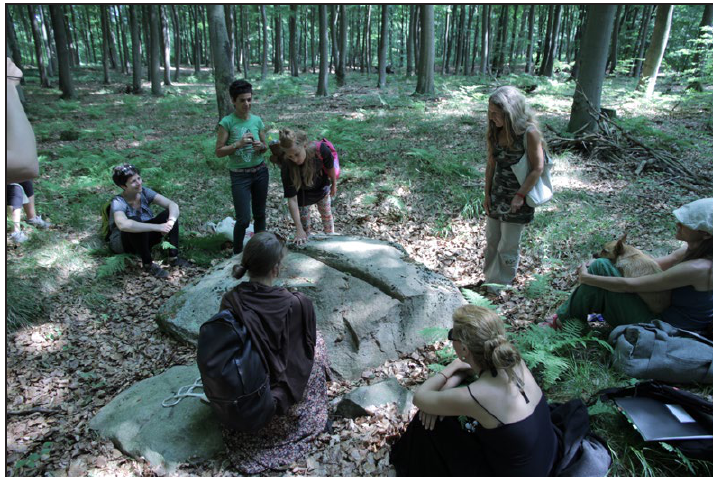
Figure 6: Deirdre Donoghue, ‘The Maternal as an Attitude, Maternal Thinking and The Production of Time and Knowledge’ (2013–2014). Note from the artist: This photo- graph is taken at the launch of the artistic research project ‘The Maternal as an Atti- tude, Maternal Thinking and The Production of Time and Knowledge’ (2013–2014) initiated by Deirdre M. Donoghue and kindly supported by Witte de With Cen- tre for Contemporary Art. This first public event, which took form as a picnic com. workshop was a collaboration between Deirdre M. Donoghue, Witte de With Cen- tre for Contemporary Art (NL), the artist’s initiative Oda Projesi from Istanbul (TR), Astrid Noack’s Ateliers (DK) and a group of local mother artists and mother schol- ars living in